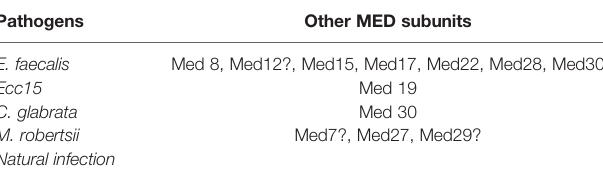
TABLE 3 | Other Med subunits in host defense against other